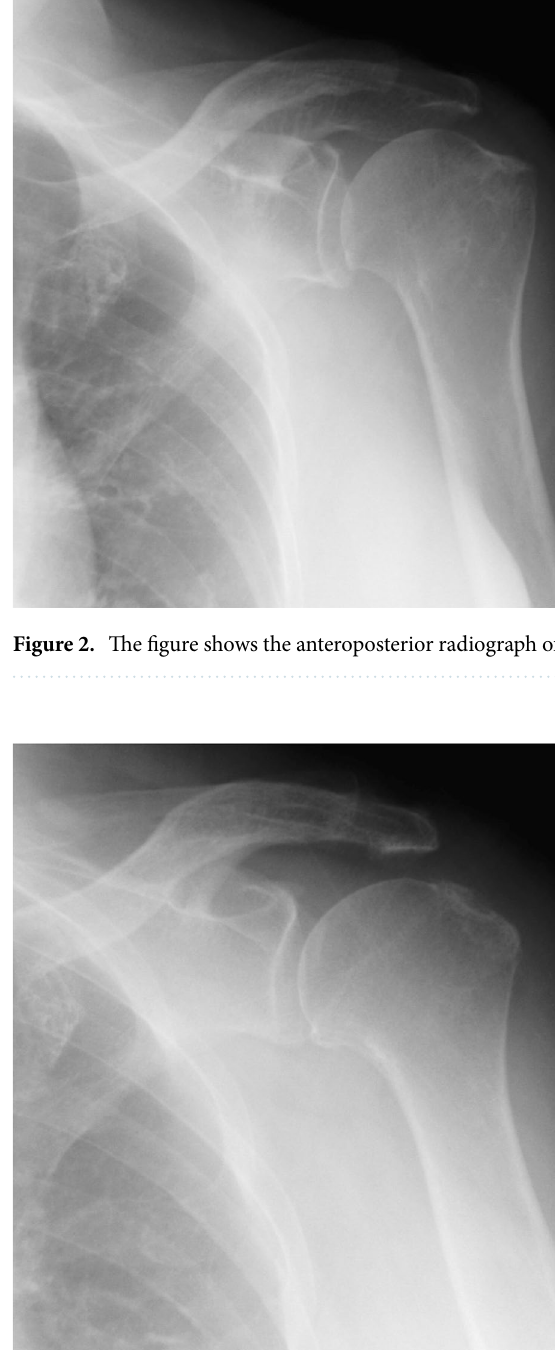
into No progression and Progression group. The differences between the subgroups were analyzed in a similar fashion to the initial analysis. Shoulders without RCT were used to determine the risk factors of RCT onset, and shoulders with RCT were used to determine the risk factors of RCT progression. A stepwise logistic regression analysis was performed to identify the risk factors of RCT onset or progression in 2017 using the following factors in 2012 as explanatory variables: age, gender, dominant arm, manual labor, ROM, the presence of pain, ROM, the presence of SSC tear,